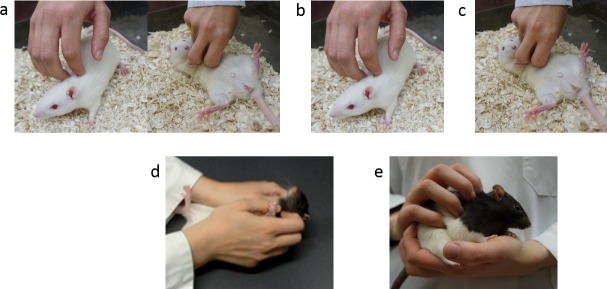
Pictorial tickling procedures.A: Dorsal contact and pin (standard, validated rat tickling procedure), B: Dorsal contact only or stroking in the cage, C: Pin only, D: Two-handed pin only, E: Stroking in the hand.